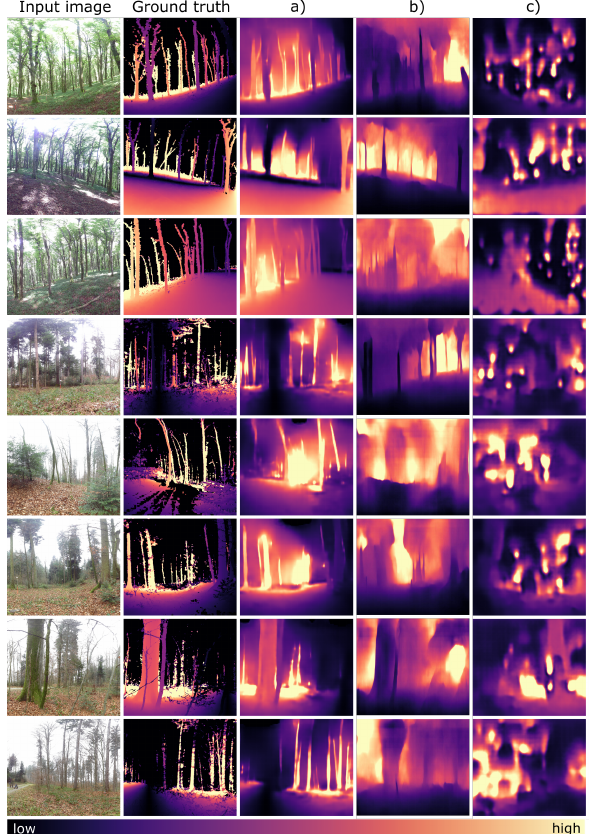
Figure 3. Predicted depth maps computed using a) our method, b) (Godard et al., 2019), and c) (Ma and Karaman, 2018). Purple areas in all depth maps signify pixels (trees) close to the camera, whereas yellow areas illustrate more distant pixels (trees). Black corresponds to zero-value pixels.